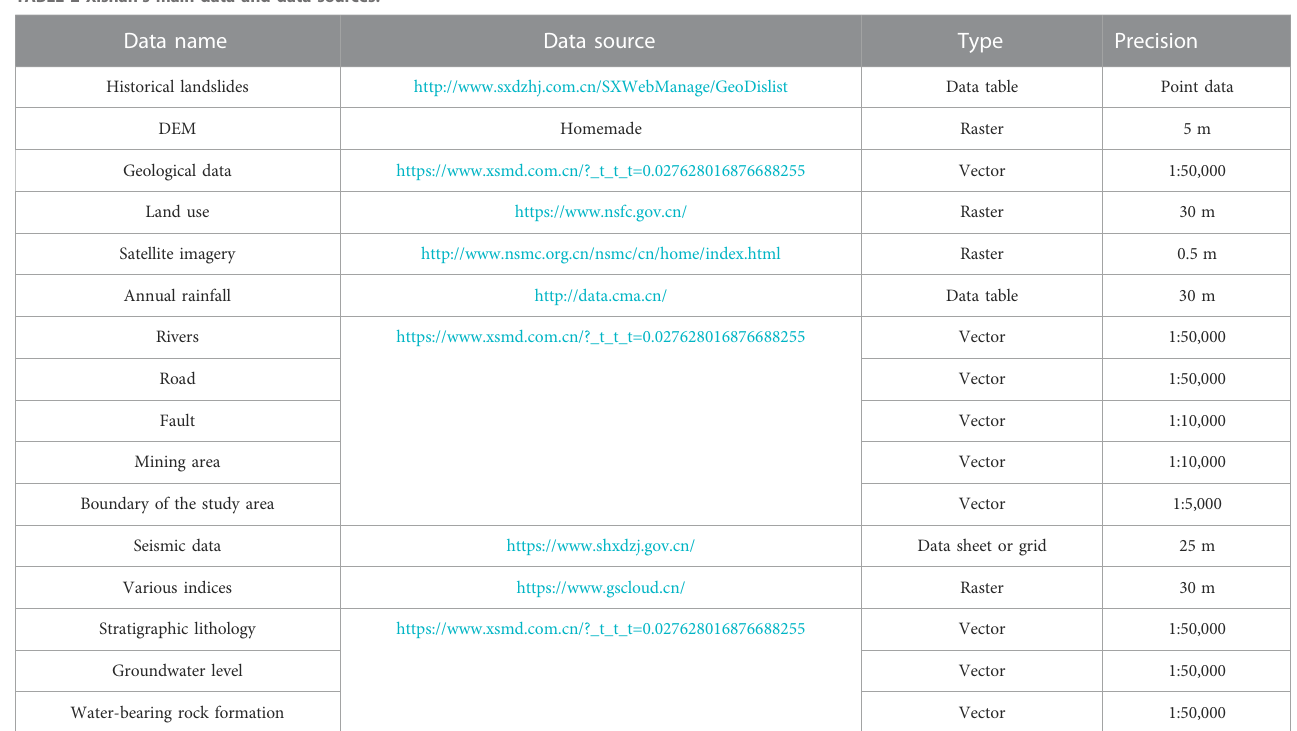
TABLE 2 Xishan ’ s main data and data